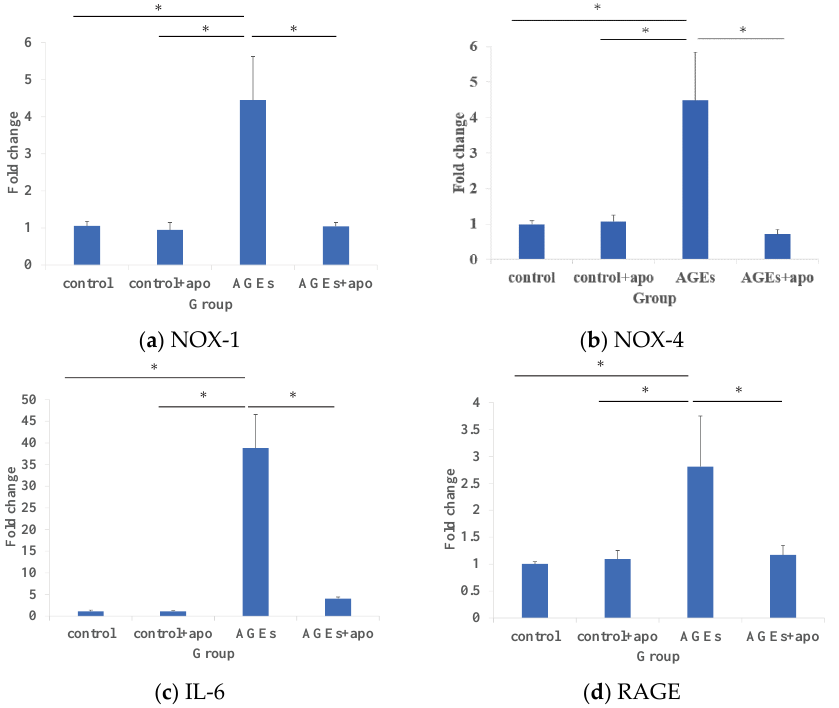
Figure 1. ( a ) Expression of NOX-1 mRNA in the AGEs group was significantly higher than in the other groups at 48 h. ( b ) Expression of NOX-4 mRNA; ( c ) expression of IL-6 mRNA; and ( d ) expression of RAGE mRNA showed similar findings to that of NOX-1. * p < 0.05. 3.2. Apocynin Resulted in Inhibition of Decreased RC-Derived Cell Viability with AGEs Stimulation At 48 h, cell viability in the AGEs group was significantly lower than that in the con- trol and control + apo groups ( p < 0.05, p < 0.05, respectively) (Figure 2). That in the AGEs + apo group was also lower than in the control and control + apo group, though there was no significant difference (Figure 2). Alternatively, that in the AGEs + apo group was sig- nificantly lower compared to the AGE+ group ( p < 0.05) (Figure 2)